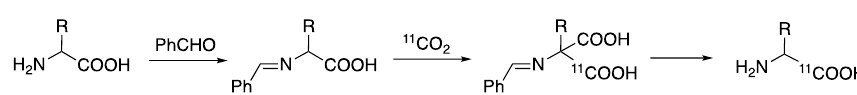
Fig. 1 Synthetic scheme for synthesis of 11 C-amino acids through isotopic exchange catalyzed by